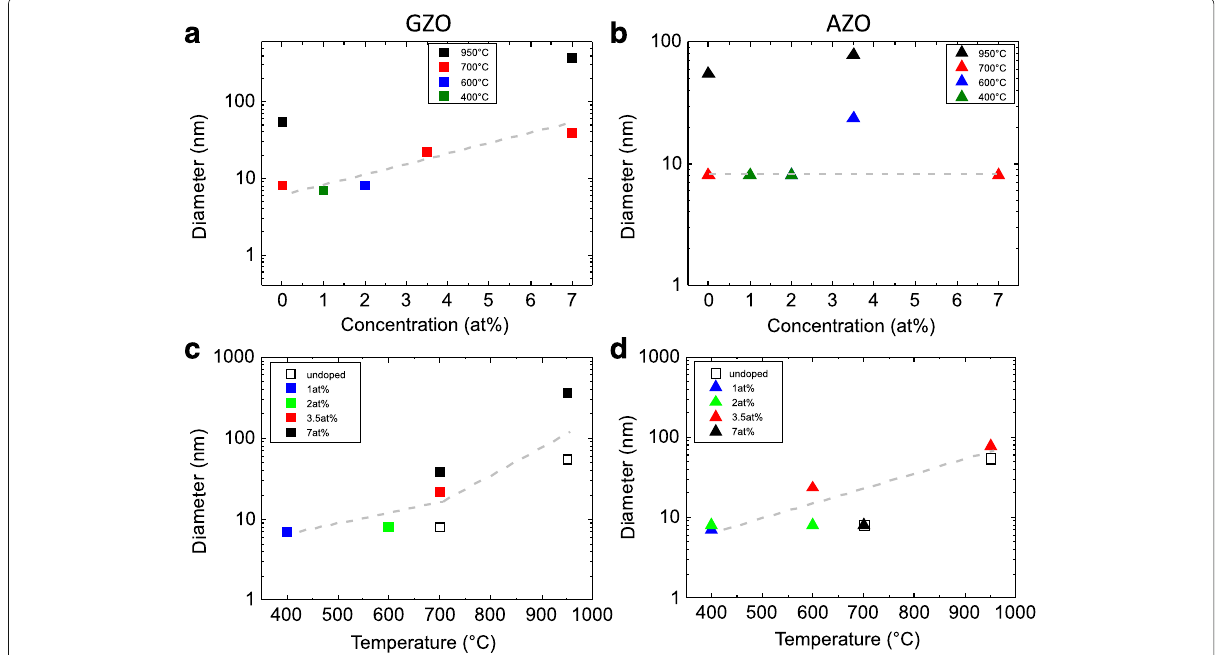
Fig. 4 The diameter of the NWs as a function of the doping concentration ( a , b ) and growth temperature ( c , d ) for the Ga-doped ( a , c ) and Al-doped seed layers ( b , d ). The graydashedlines are guides for the eyes